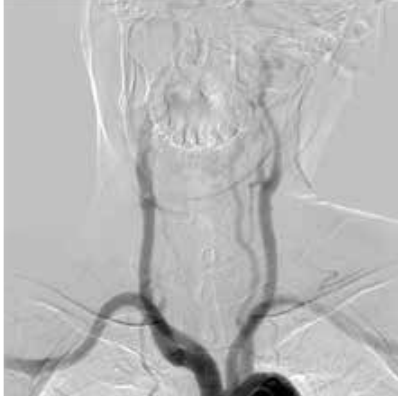
Figure 9 Positive aortic arch angiography after patient injury.